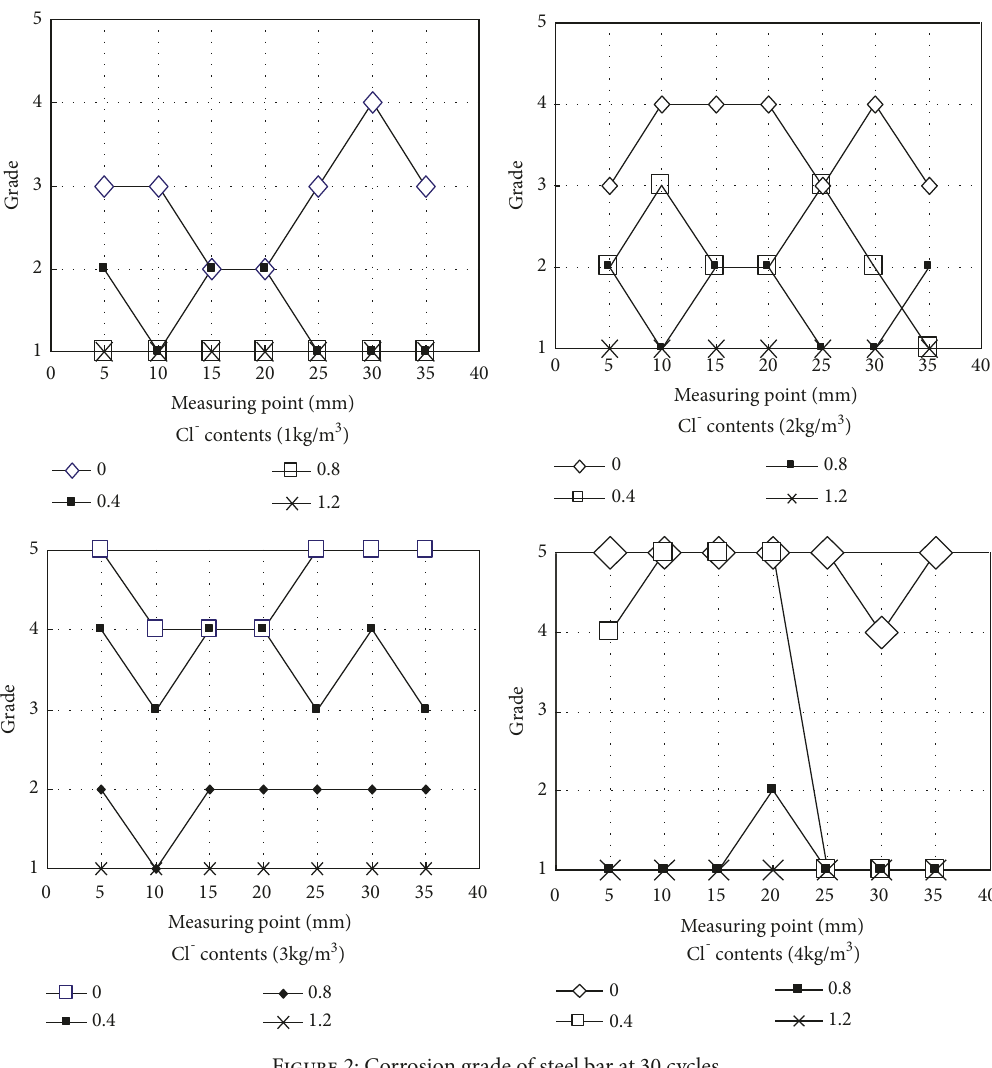
Figure 2: Corrosion grade of steel bar at 30 cycles.